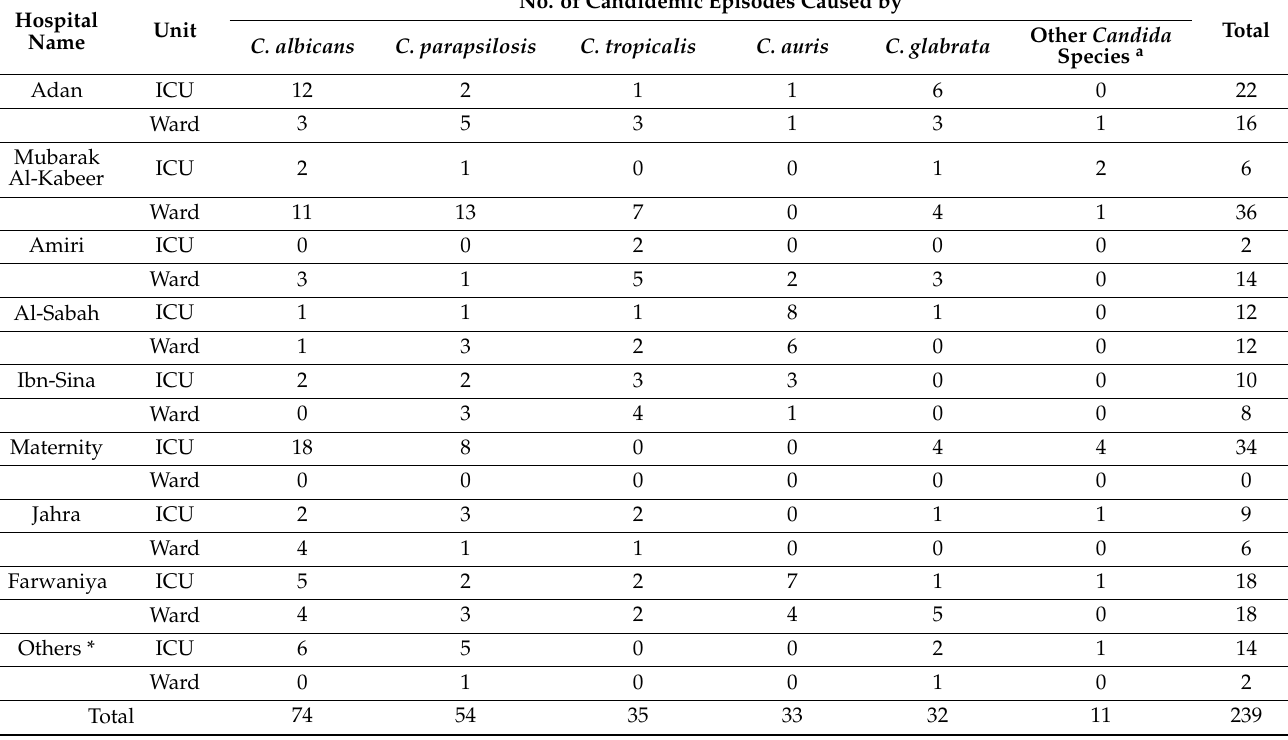
Table 5. Distribution of Candida species among candidemia patients admitted into wards and ICUs of eight major and other hospitals in